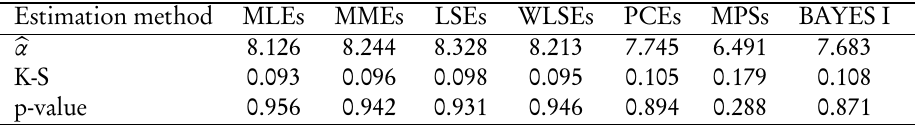
Estimates, K-S distances and corresponding p-values based on different estimates for Example 2. Estimation